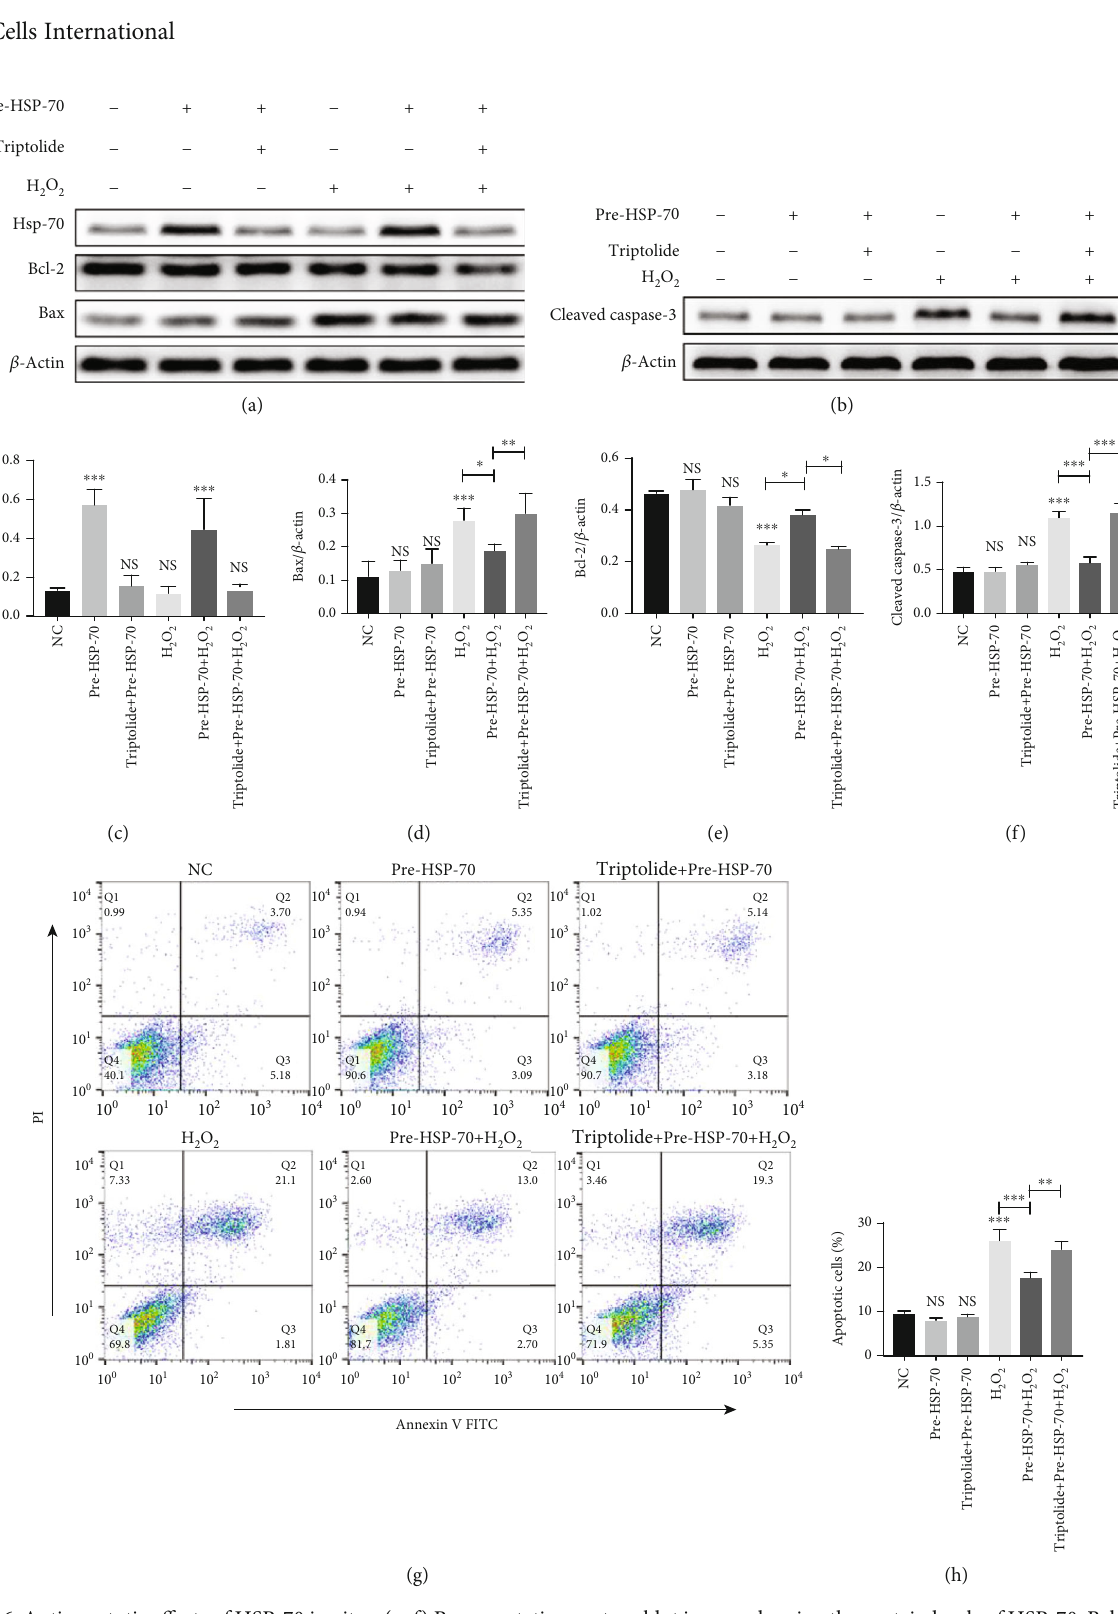
Figure 6: Antiapoptotic e ff ects of HSP-70 in vitro. (a – f) Representative western blot images showing the protein levels of HSP-70, Bcl-2, Bax, and cleaved caspase-3. β -Actin was used as an internal control. (g) Representative dot plots of cell apoptosis were showed after Annexin V/PI dual staining. (h) The percentage of apoptotic cells was represented for both early and late apoptotic cells. Every experiment was repeated at least three times. Error bars indicate mean ± SD ( ∗ P < 0 : 05 ; ∗∗ P < 0 : 01 ; ∗∗∗ P < 0 : 001